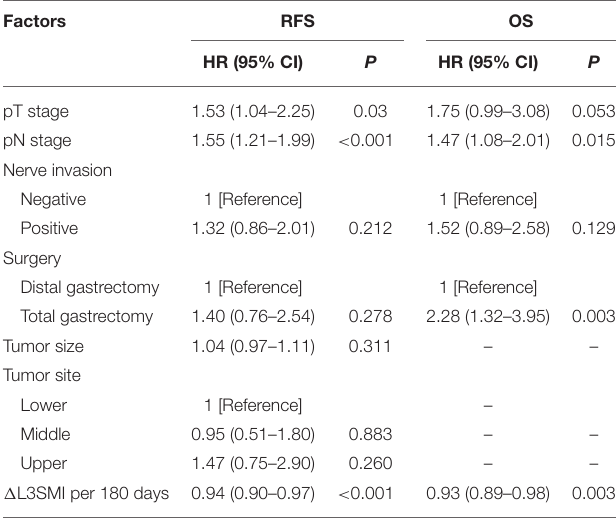
TABLE 3 | Selected variables according to the cox proportional hazards regression